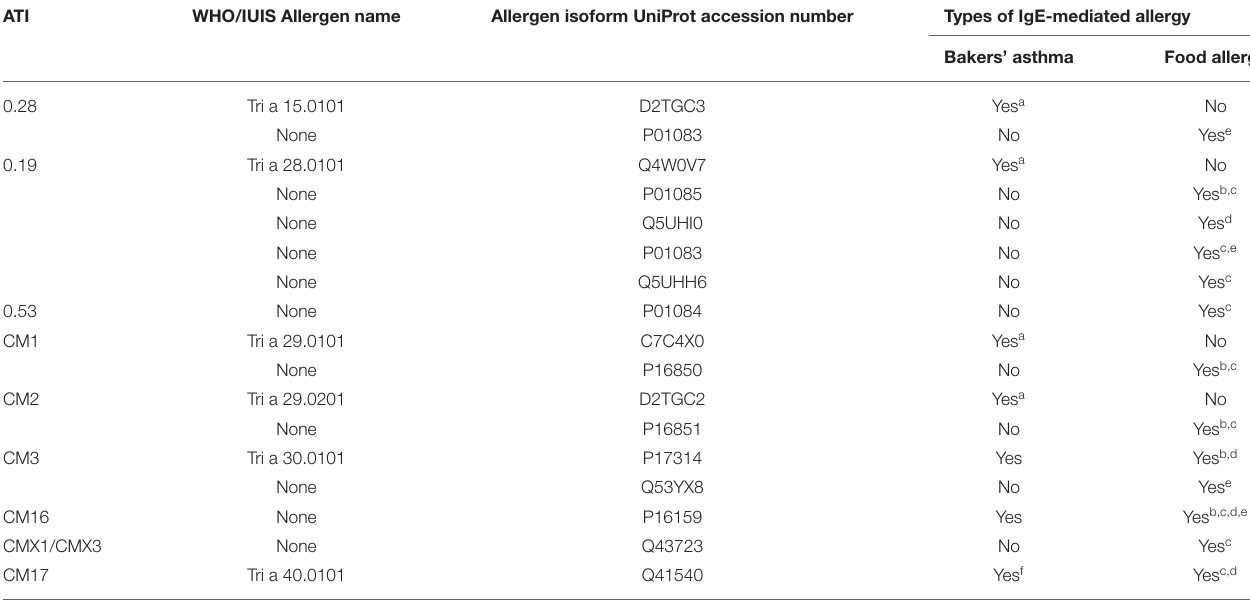
TABLE 2 | ATIs shown to elicit allergic responses. ATI WHO/IUIS Allergen name Allergen isoform UniProt accession number Types of IgE-mediated allergy